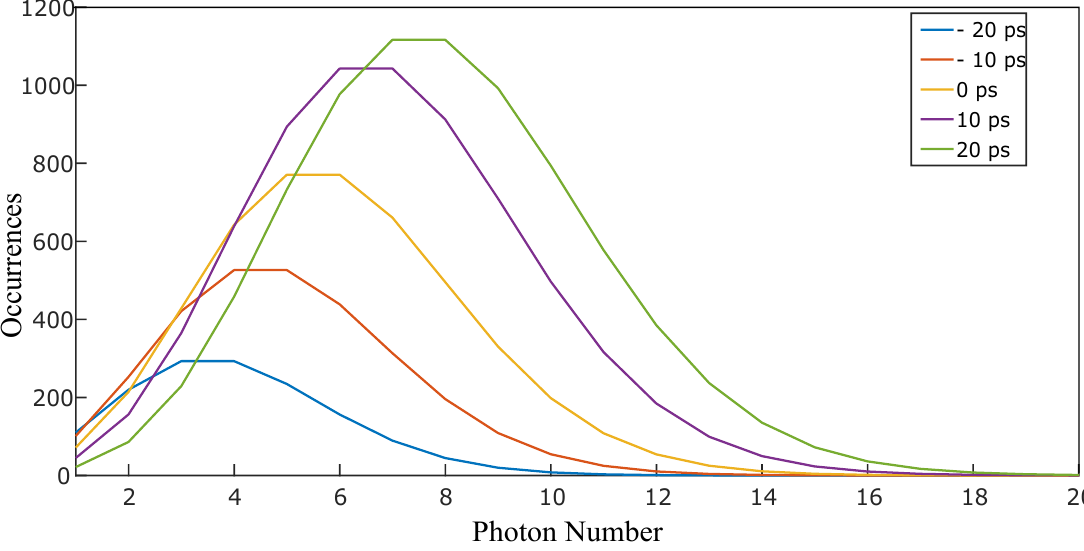
Figure 5. The Poisson distributions have been extrapolated from the Gaussian plus Poisson function fitted to the histograms of photon counts of the laser